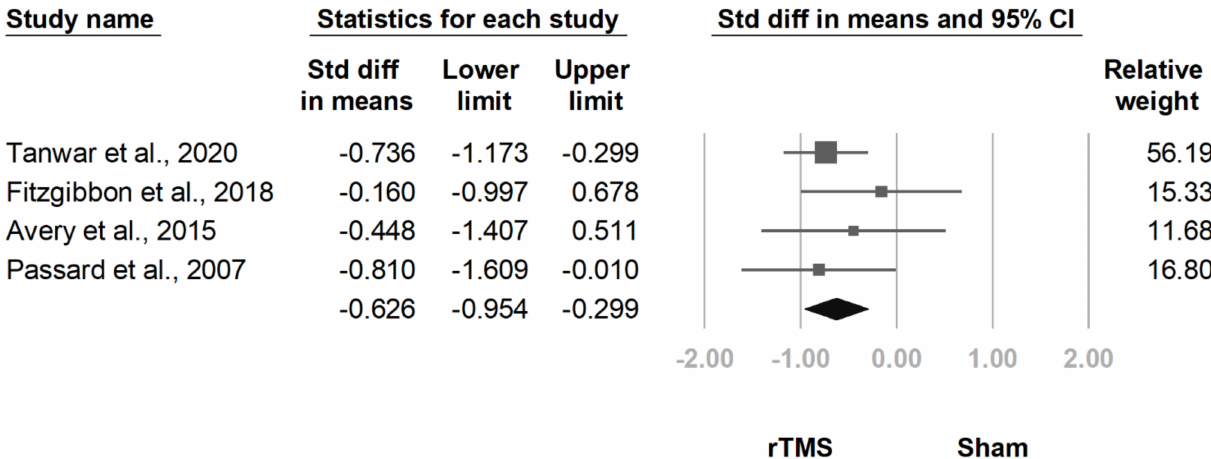
Figure 11. Forest plot of standardized mean differences in McGill Pain Questionnaire after treatment. Squares indicate effect sizes of individual studies, lines indicate 95% CI, and diamond indicates the summarized effect size.